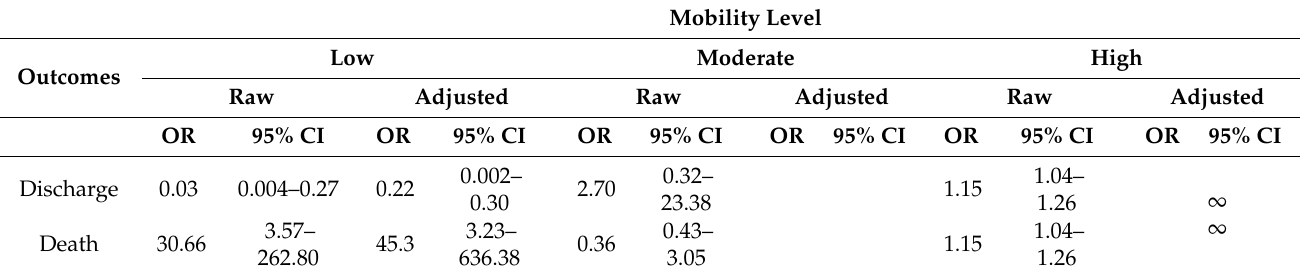
Table 3. Crude and adjusted analysis of outcomes associated with exposure to low mobility, moderate mobility, and high mobility in the